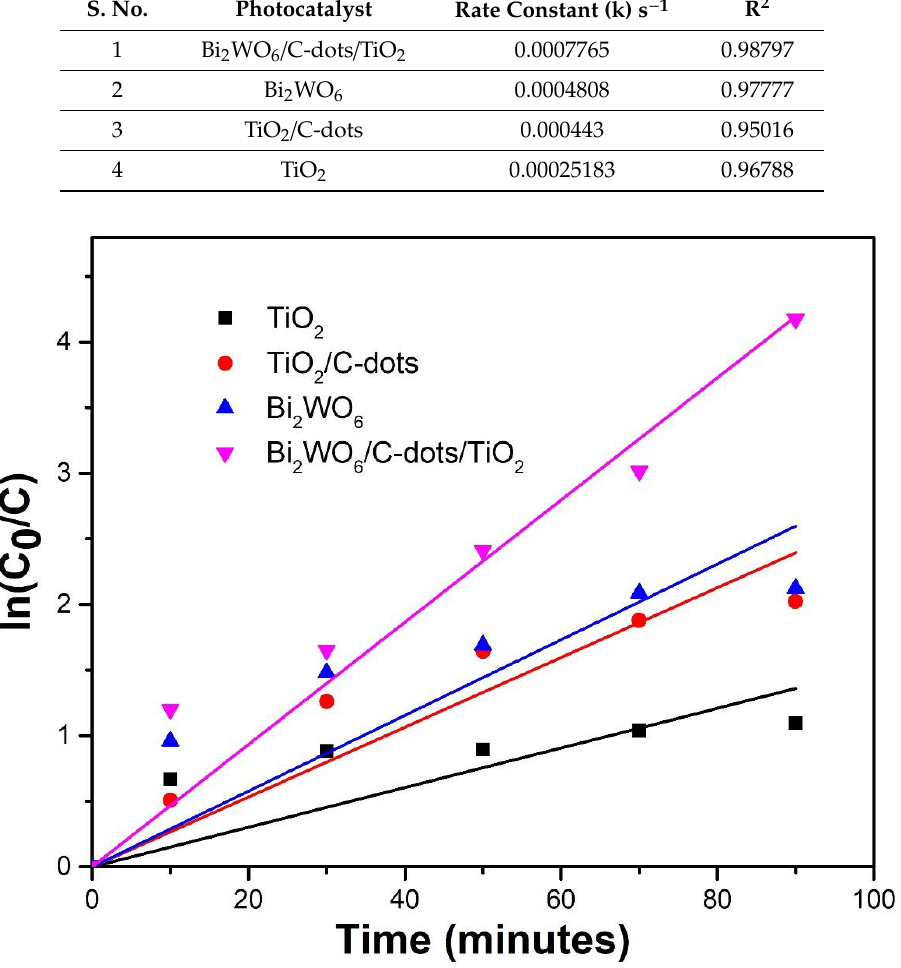
/ C ) against time depicting the kinetics of photocatalytic Figure 10. Graph of ln(C 0 /C) against time depicting the kinetics of photocatalytic reaction. Figure 10. Graph of ln ( C 0